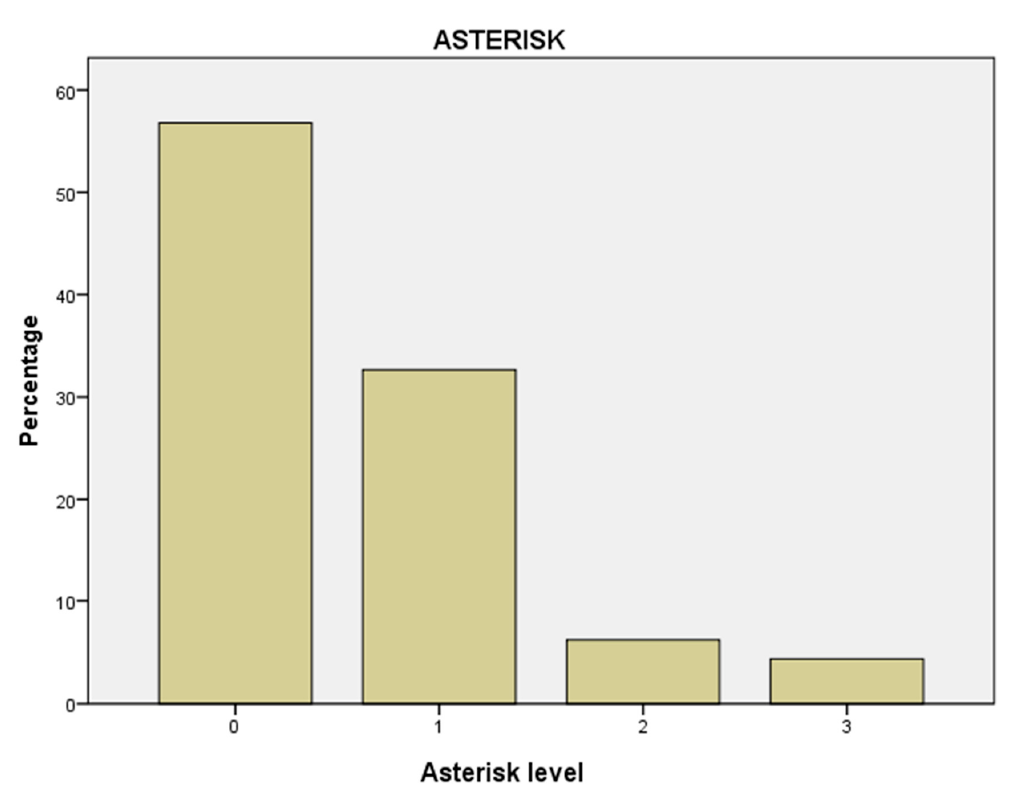
Figure 2. Percentage of students in each asterisk level (ASTERISK).